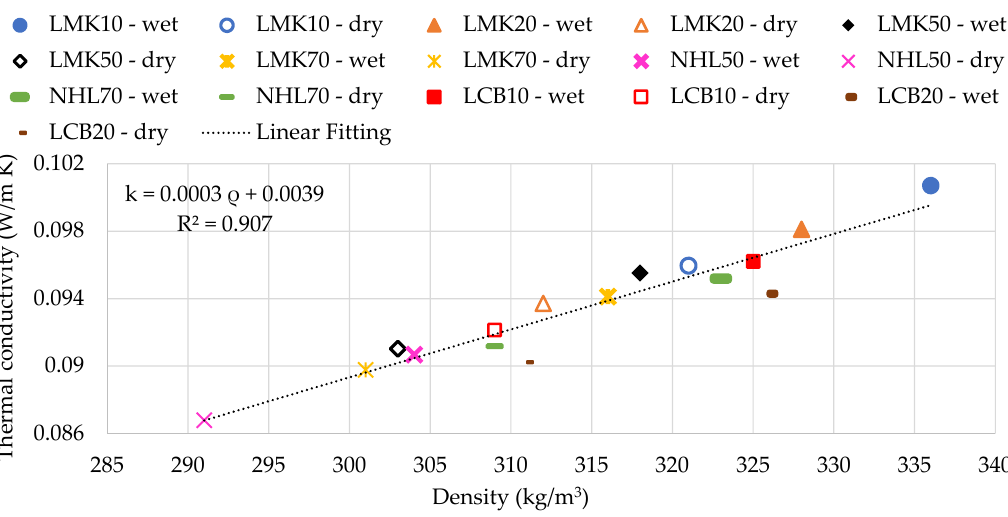
Figure 3. Thermal conductivity as a function of density.